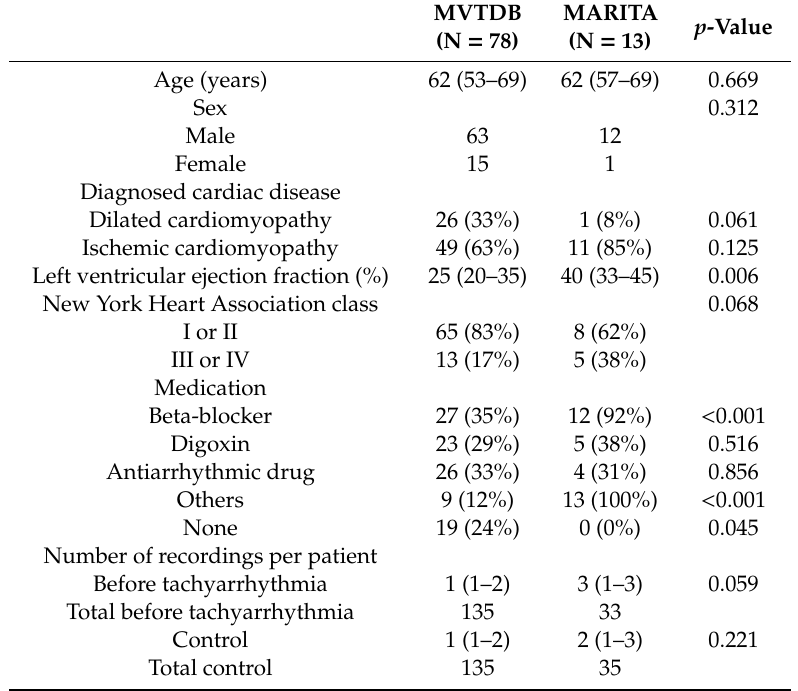
Table 1. Clinical characteristics of patients and number of recordings per patient for both datasets. The statistical significance of the di ff erence between databases is shown in the p -value